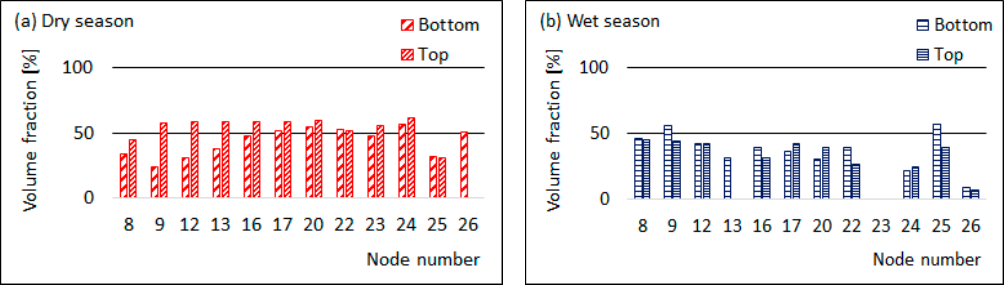
Figure 5. Trend for particles with size corresponding to helminth eggs for wet ( a ) and dry ( b )